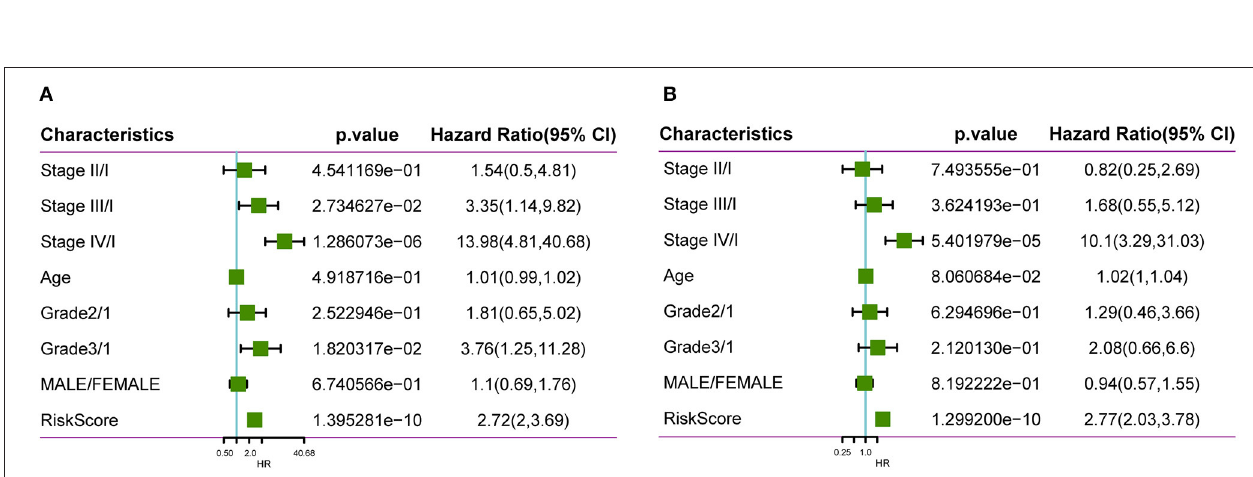
Frontiers in Oncology |